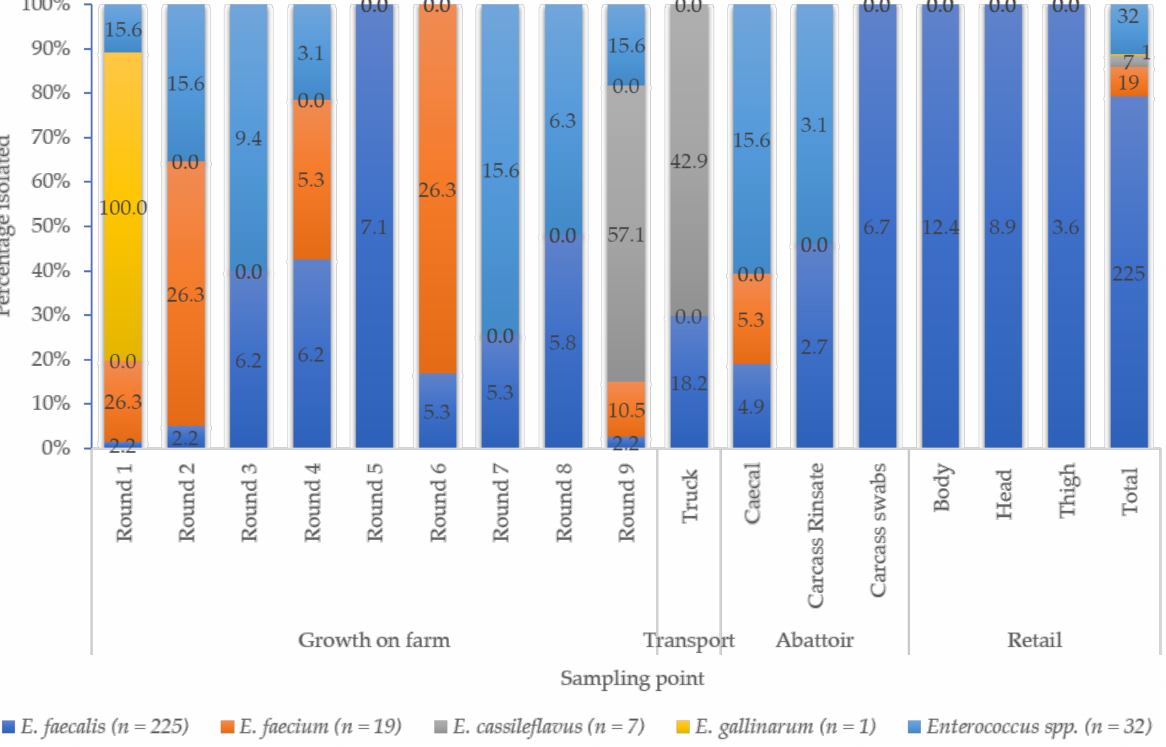
Figure 2. Distribution of various Enterococcus species along the farm-to-fork